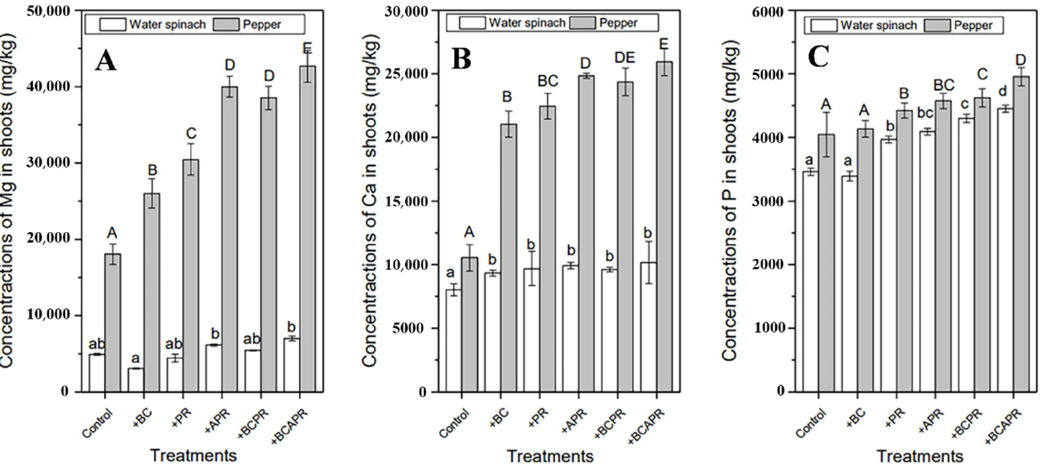
Figure 4. Mg ( A ), Ca ( B ), and P ( C ) uptake by water spinach and pepper with different amendments. The number of replicates was three. Different lowercase letters indicate significant differences in water spinach at p < 0.05. Different capital letters indicate significant differences in pepper at p < 0.05. BC: biochar, PR: phosphate rock, APR: activated phosphate rock, BCPR: composite of biochar and phosphate rock, BCAPR: composite of biochar and activated phosphate rock.